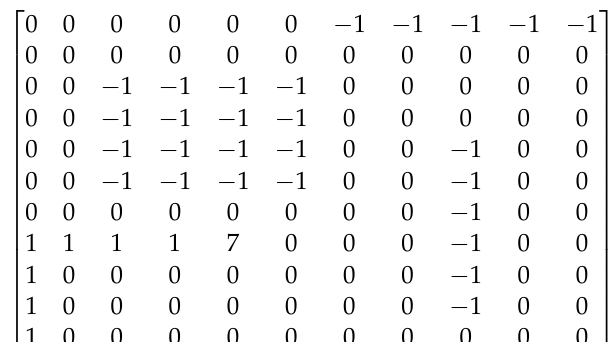
Figure 6. A state in the